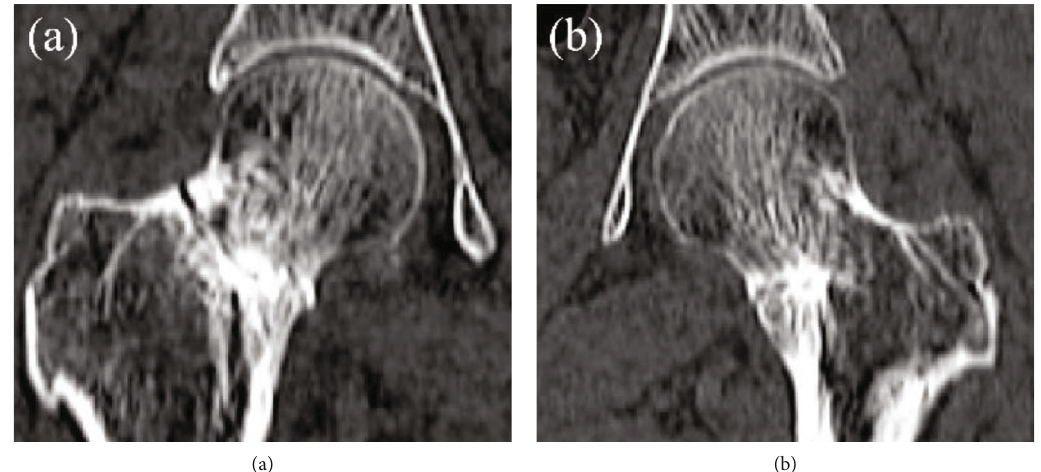
Figure 2: Computed tomography coronal image demonstrating a circumferential fracture and surrounding osteosclerosis of the femoral neck on the right side (a) and the medial fracture on the left side (b).